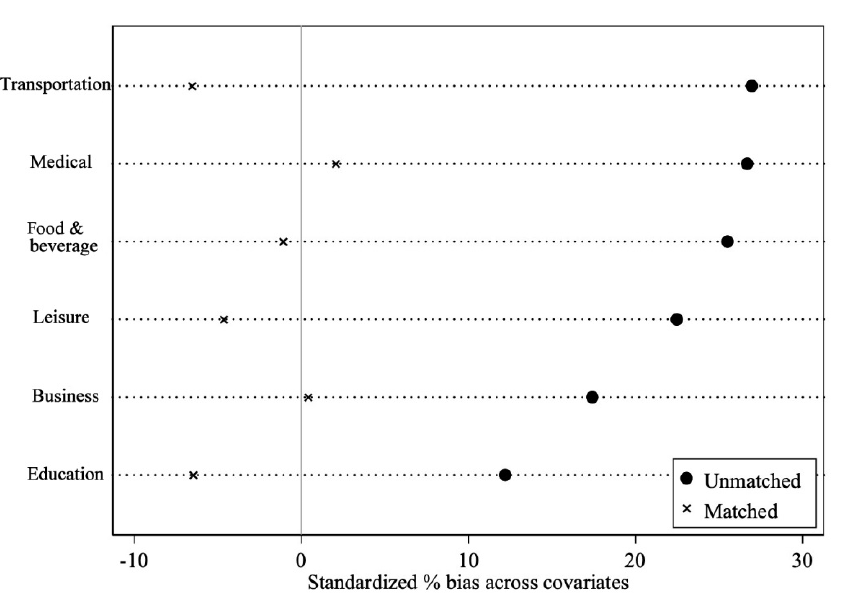
Figure 2. Balance test results for PSM.